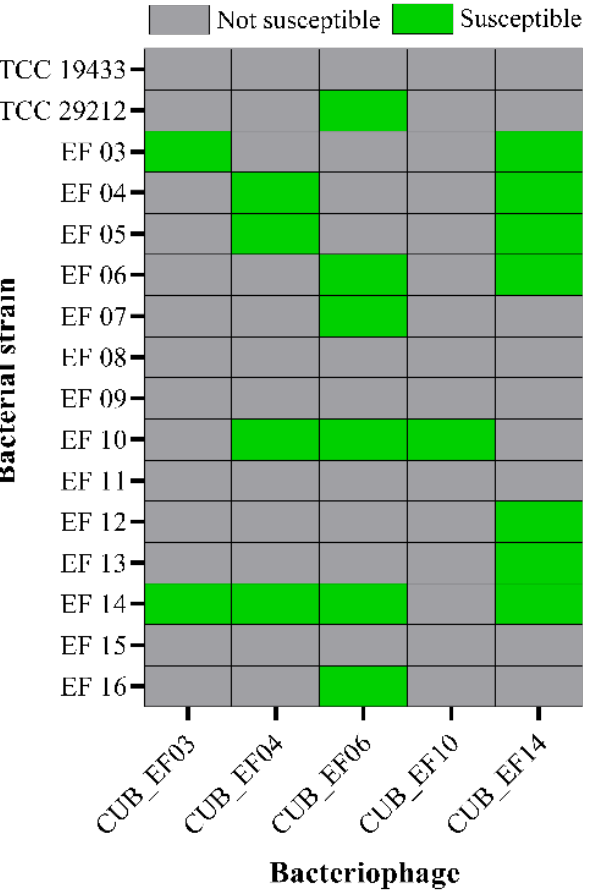
Figure 2. Host range of isolated bacteriophages among E. faecalis strains.